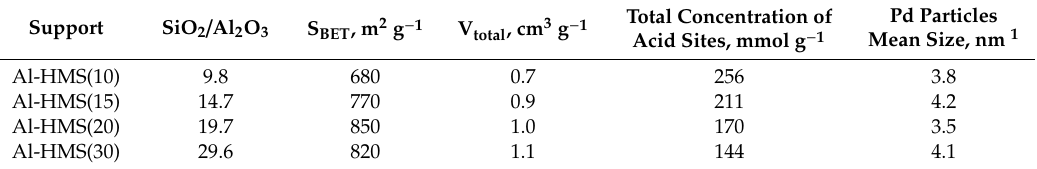
Table 3. The physicochemical properties of the Al-HMS-supported catalysts.